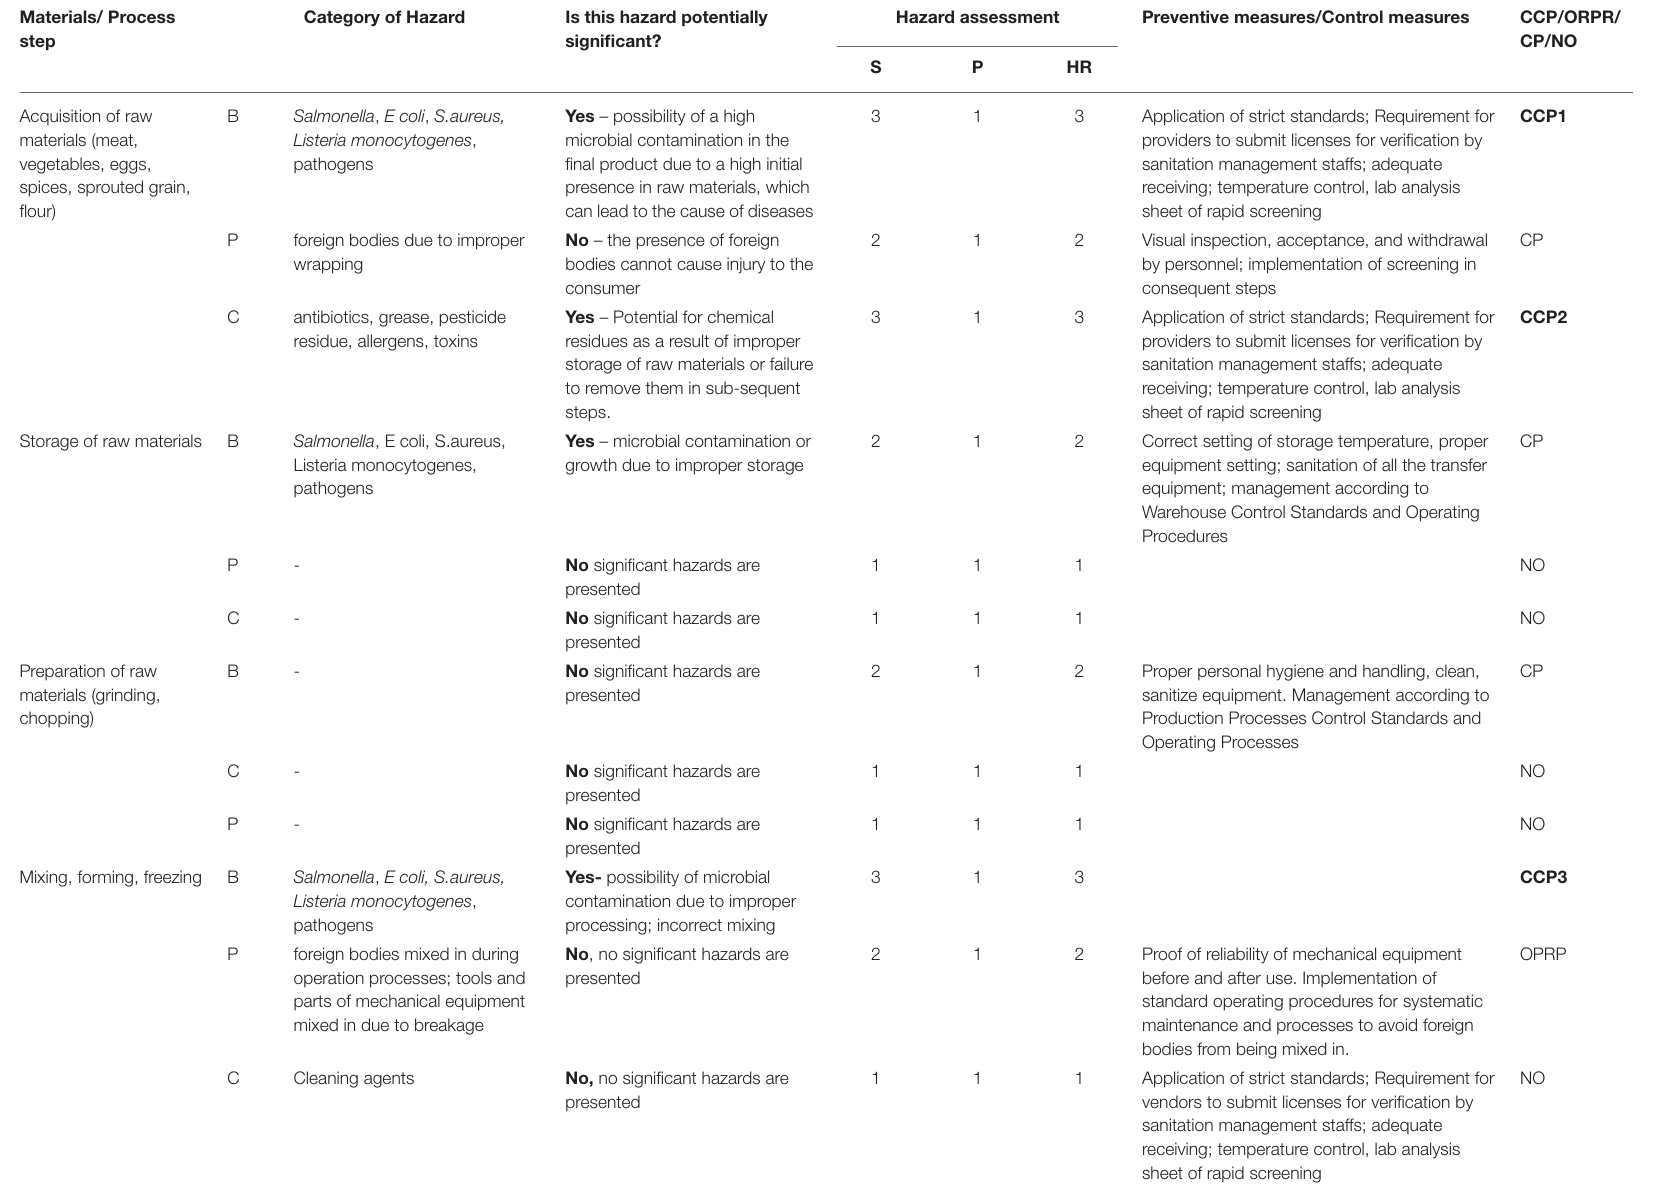
TABLE 3 | Hazards analysis and CCP determination chart of the patties production. Materials/ Process